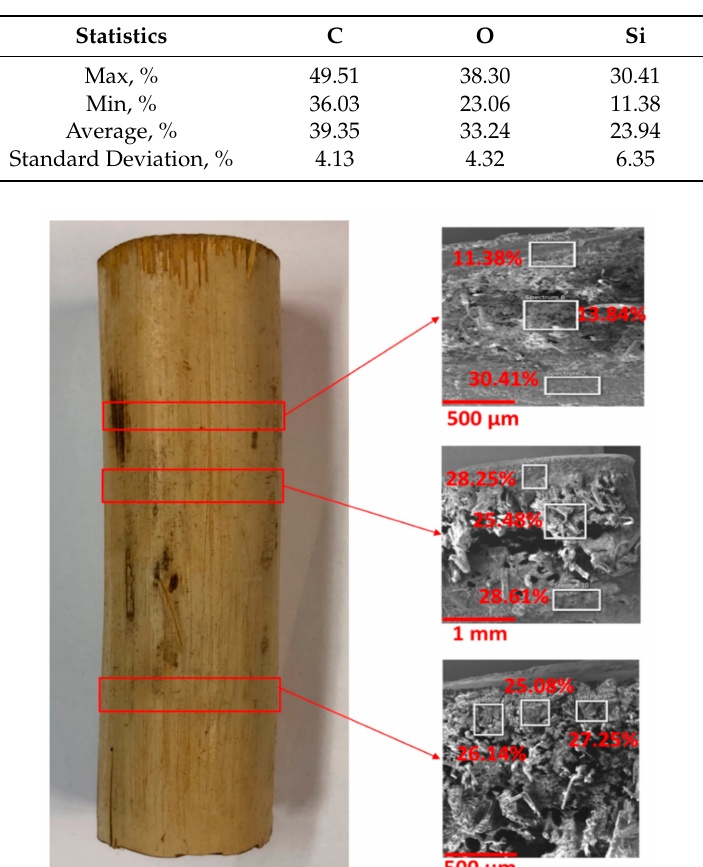
Figure 2. EDS analysis of plastinated bamboo denoting Si content. The variation of silicon denotes a concentration gradient with a lower concentration in the middle of the